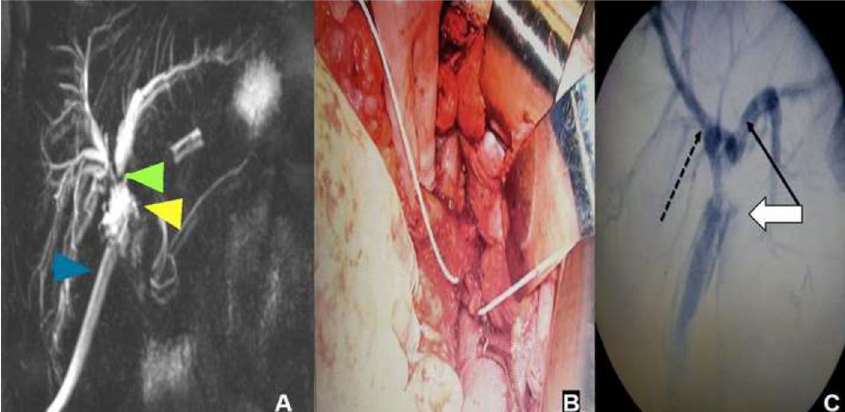
Fig. 7 3D-MRCP ( a ) post-cholecystectomy with non-visualized confluence between the right and left hepatic bile ducts “green arrowhead” with mild intra-hepatic biliary backpressure changes. The site of the CHD is replaced by a small biloma “yellow arrowhead”. Percutaneous drainage catheter is noted “blue arrowhead” . Strasberg Type E4; Bismuth-Corlette Type 4 bile duct injury. Intraoperative photography ( b ) shows the distance between the right and left bile ducts. Intraoperative cholangiography ( c ) after injection of the contrast media through the separate drains, confirming loss of communication between right “black dashed arrow” and left “black arrow” hepatic ducts with bile leak “white